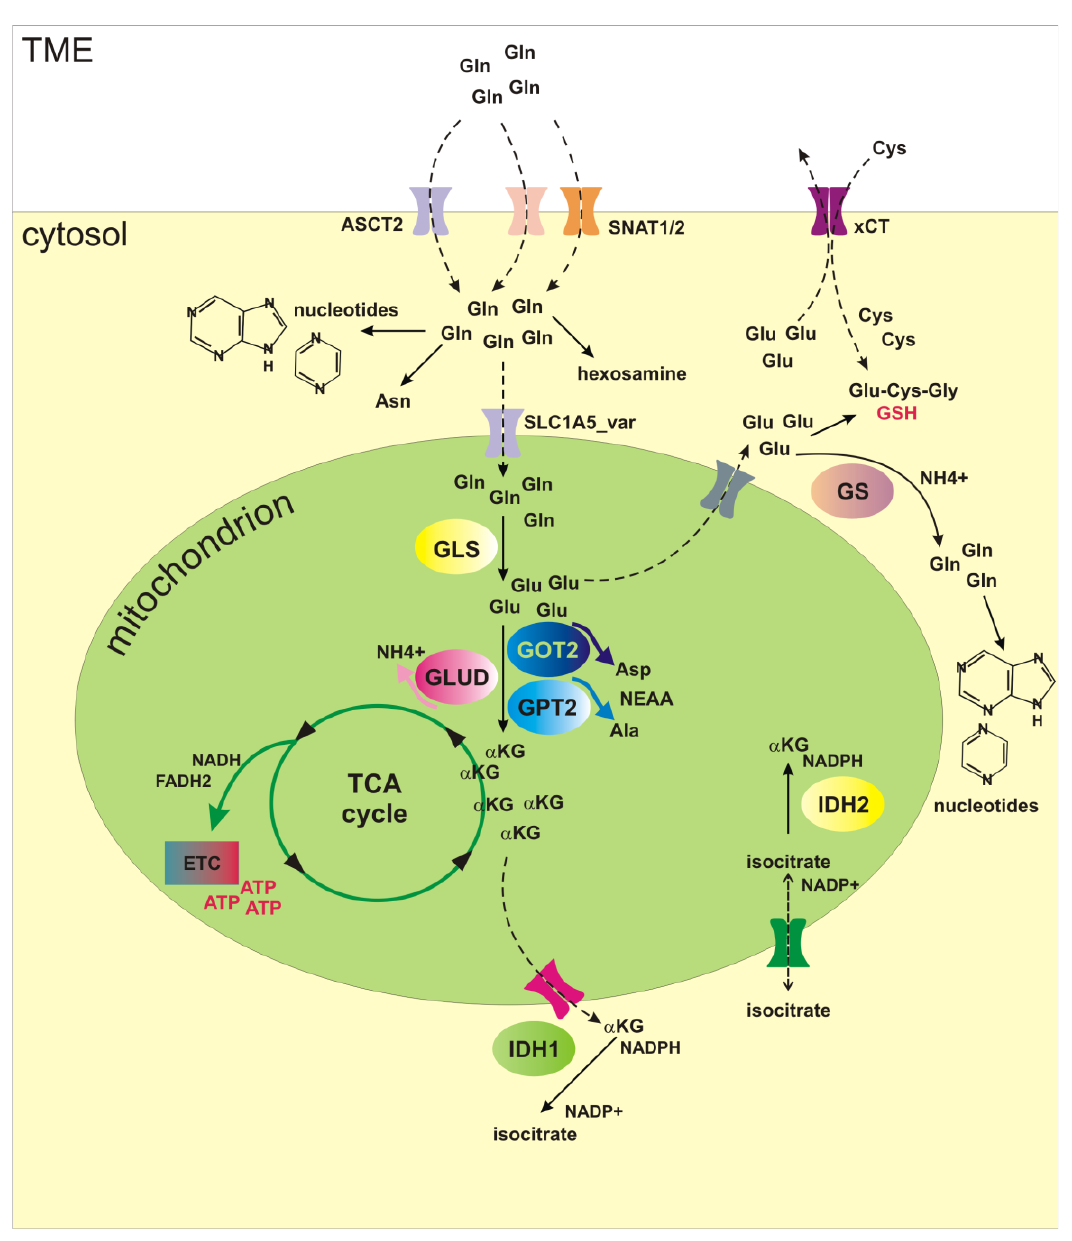
Figure 1. Overview of glutamine metabolism. Glutamine (Gln) is imported into the cytosol through various transporters (ASCT2, SNAT1, SNAT2). In the cytosol Gln acts as precursor for biosynthesis of asparagine (Asn), hexosamine and nucleotides. SLC1A5_var transports Gln into the mitochondria, where Gln is converted to glutamate (Glu) by glutaminase (GLS). Glu in the mitochondrial matrix is converted to α - ketoglutarate (αKG), either by glu tamate dehydrogenase 1 (GLUD1) or by mitochondrial transaminases (GPT2, GOT2). Glu deamidation by GLUD1 is associated to production of ammonia (NH4+), whereas the conversion of Glu to αKG via transaminases is coupled to synthesis of non-essential amino acids (NEAA), aspartate (Asp) and alanine (Ala). GLS and transaminases are present both into the cytosol and into the mitochondria. The αKG enters the